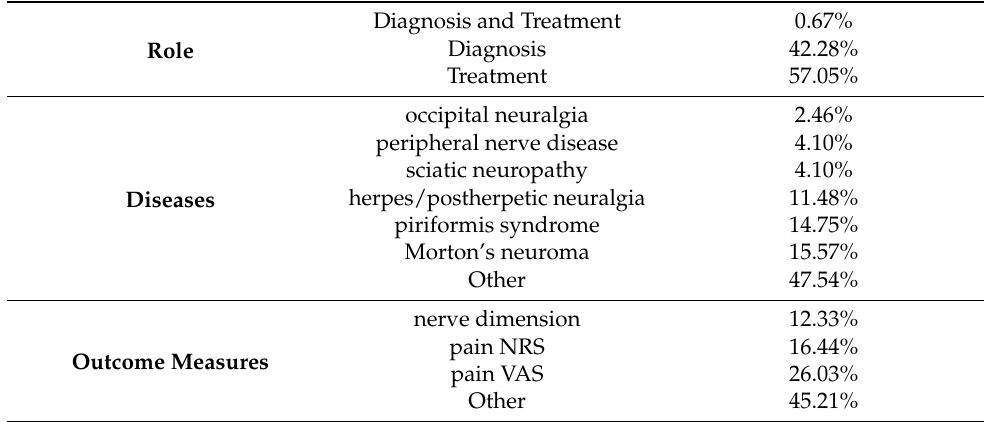
Table 1. Presentation of the most frequent